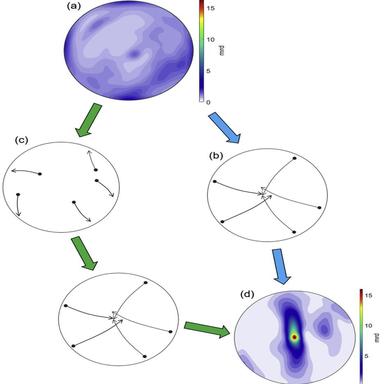
Schematic outlining the possible routes to a basal texture from the starting workpiece texture: (a) (0002) Pole figure for the as-received material. (b) Basal pole rotation during tensile twinning. (c) Basal pole rotation in which the specific slip or twinning system involved depends on prior orientation followed by tensile twinning. (d) The basal texture in the white layer.